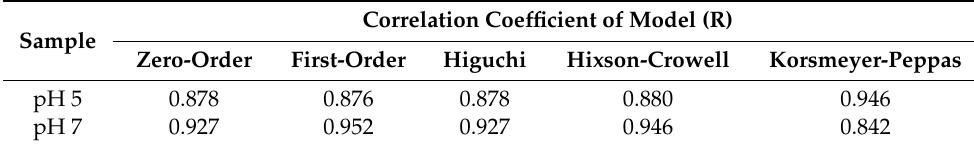
Figure 6. Cumulative release of Ru-PIP from MSNs. Table 5. Model Fitting for Ru-PIP@MSN release in pH 5 and pH